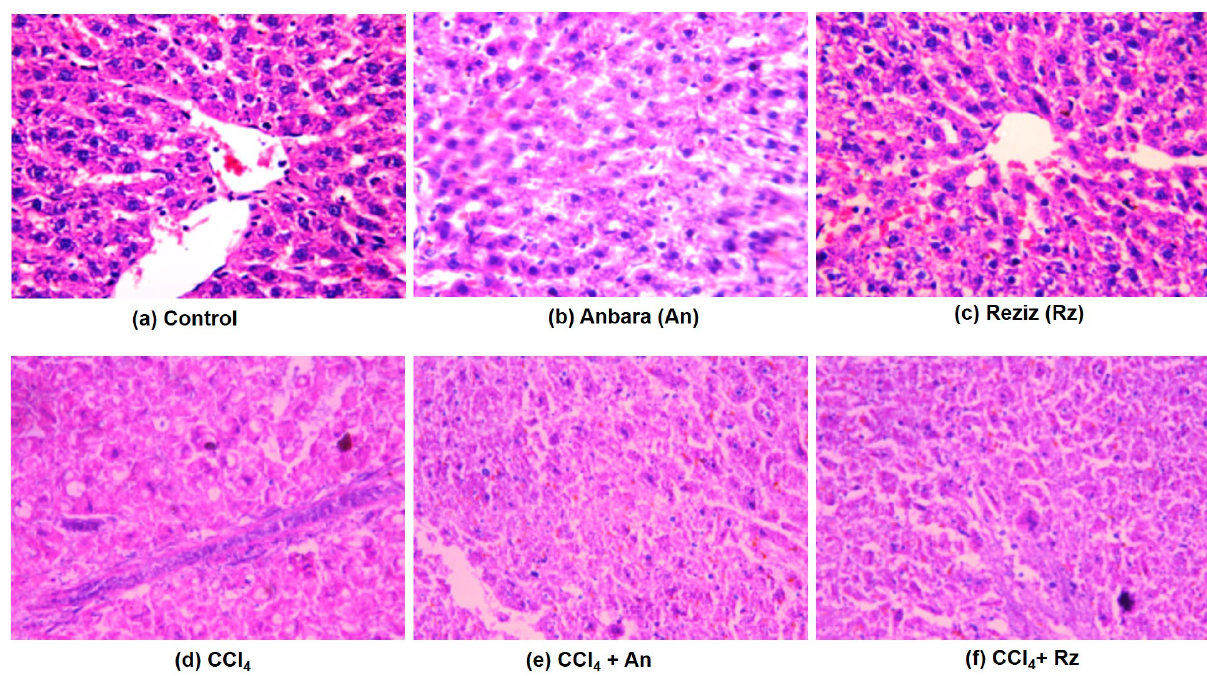
Figure 5. Histological examinations of the haptic sections’ staining by H&E of ( a ) normal, ( b ) An, and ( c ) Rz groups showing normal hepatic architectures, ( d ) CCl 4 group exhibiting congested portal vein, leucocytic infiltration, activated Kupffer cells, congested central vein, and cytoplasmic vacuolation of hepatocytes with micro and macro-vesicular steatosis and fibrosis, ( e ) CCl 4 + An revealing slight portal vessel congestion, and ( f ) CCl 4 + Rz manifesting slight degeneration of hepatocytes infiltrated with leucocytes (H&E, ×400).